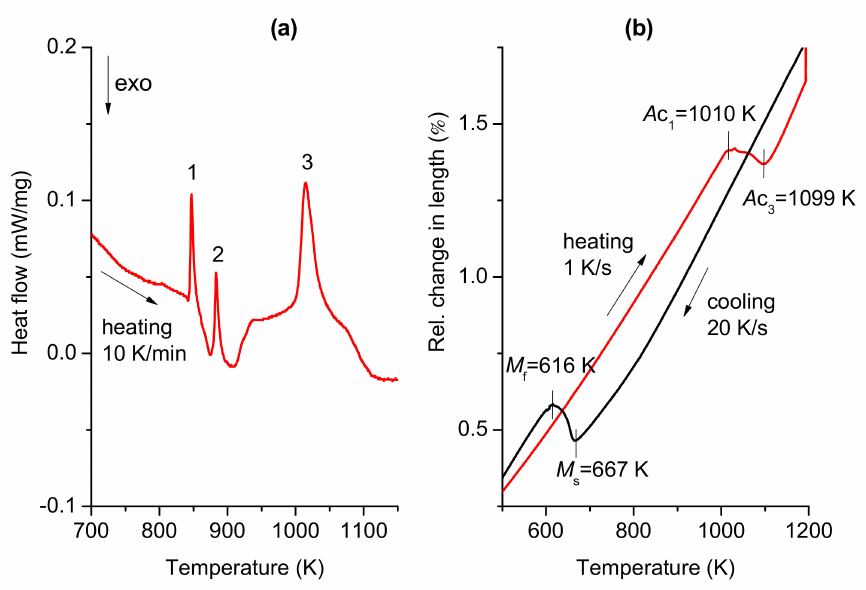
Figure 4. DSC ( a ) and dilatometric ( b ) curves of as-received Al-Si coated